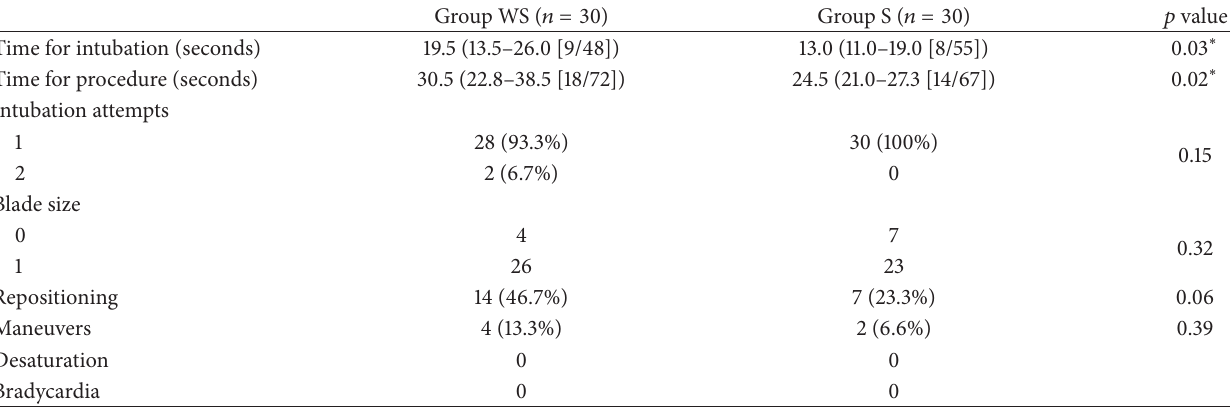
Table 2: Comparison of intubation conditions between two groups. Data are median (interquartile range [minimum/maximum]) or number (%) ∗ significant with 𝑝 < 0.05 .